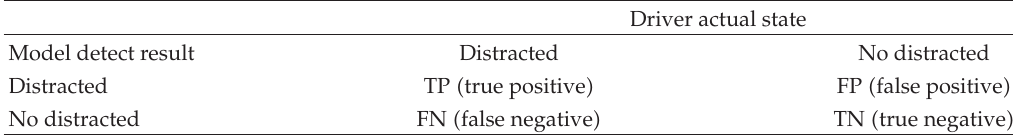
Table 2: Definition of sensitivity and specificity